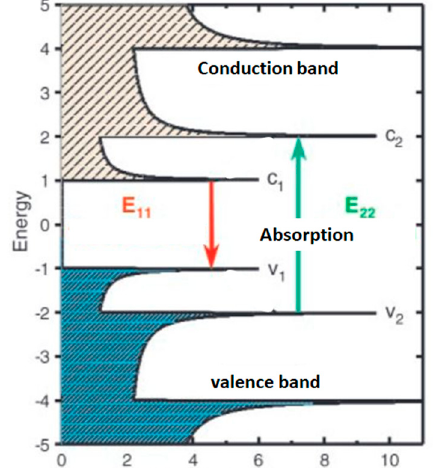
Figure 1. Scheme of optoelectronic band structure in single walled carbon nanotube by Bachilo et al. [158] reproduced with permission of the Journal of Science.